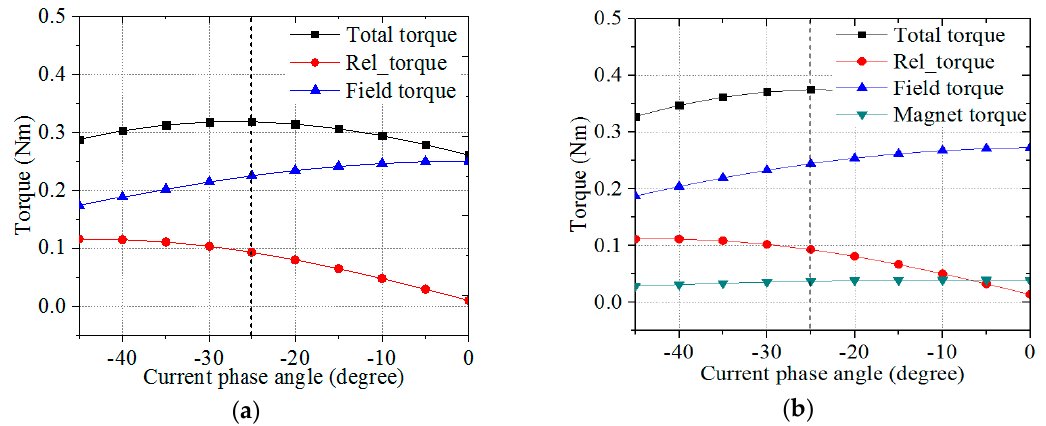
Figure 6. The torque characteristics: ( a ) Basic model; ( b ) Proposed model.